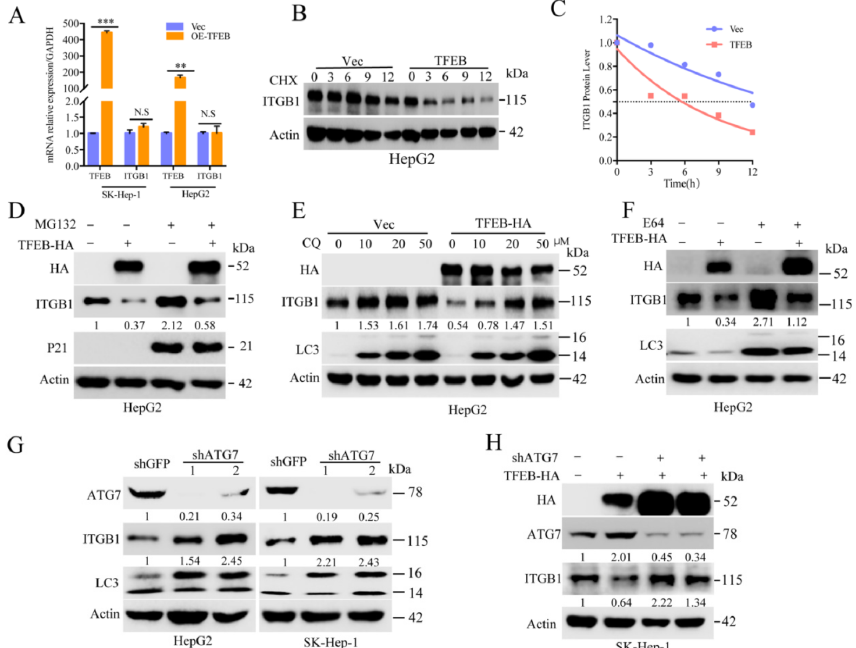
Figure 4. TFEB-induced auto-lysosomal pathway promotes integrin beta 1 degradation. ( A ) The ITGB1 mRNA levels of HepG2 or SK-Hep-1 cells stably expressing TFEB were determined by RT- qPCR analysis. The experiment was repeated three times; ( B – C ) HepG2 cells expressing TFEB or Vec were treated with 20 µ g/mL cycloheximide (CHX) for the indicated time interval, followed by Western blotting analysis. The ITGB1 levels were quantified by densitometry and the turnover rate was presented; ( D – F ) HepG2 cells expressing TFEB or Vec were treated with 10 µ M MG132 for 8 h, or a gradient of concentration chloroquine for 12 h, or 50 µ M E64 for 24 h as indicated, followed by Western blotting analysis; ( G ) HepG2 or SK-Hep-1 cells were infected by lentivirus to ATG7, followed by Western blotting analysis; ( H ) HepG2 or SK-Hep-1 cells stably expressing TFEB were infected with lentivirus encoding shATG7, and then were subjected to Western blotting analysis for ITGB1. ** p < 0.01 and *** p < 0.001. N.S. = no